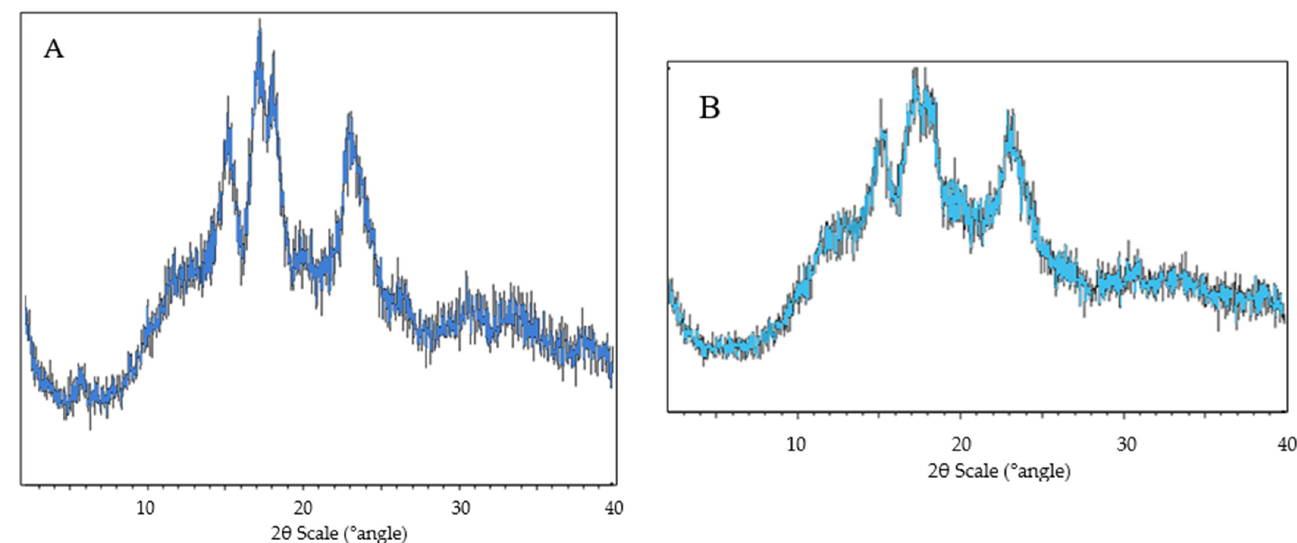
Figure 3. X-ray diffractogram of ( A ) sago starch; ( B ) pregelatinised sago starch.